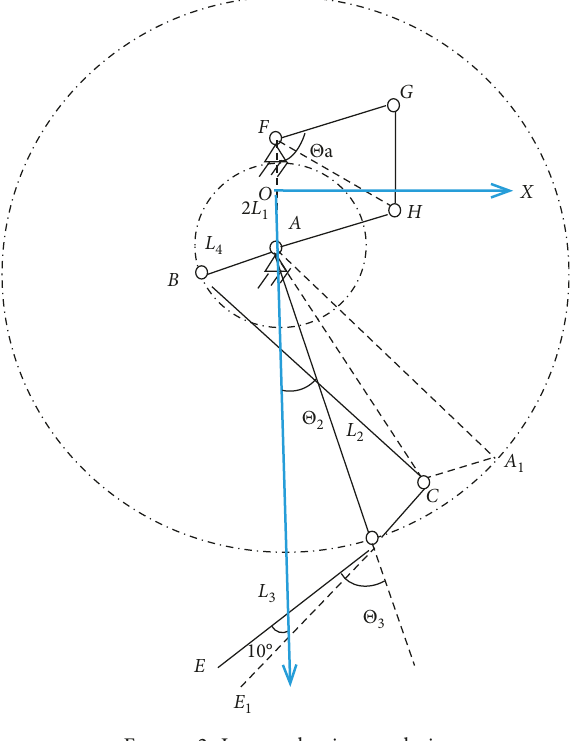
Figure 2: Leg mechanism analysis.